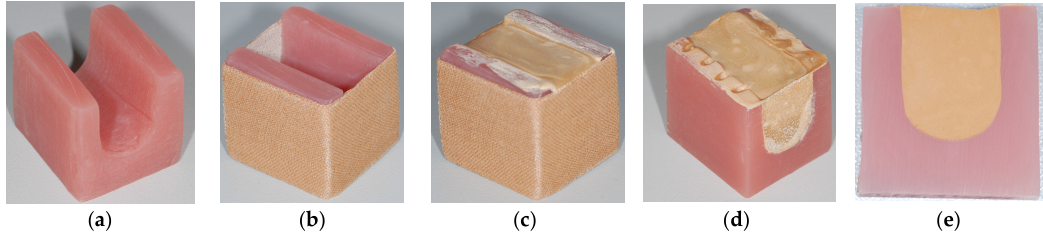
Figure 5. Specimen preparation for light microscopic measurements of chitosan coating thickness: ( a ) coating with chitosan; ( b ) wrapping with adhesive tape; ( c ) filling with stone; ( d ) removal of tape; ( e ) tranversal cutting.